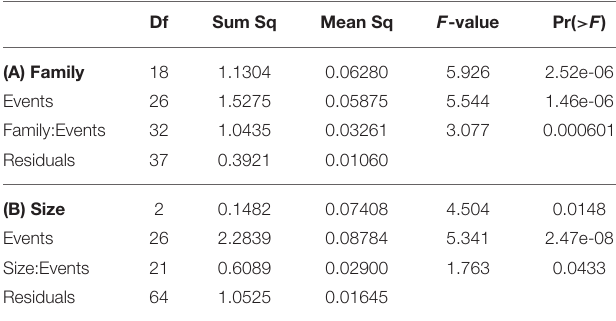
TABLE 2 | Summary of Two-Way Factorial ANOVA, testing interaction between decompression events and (A) taxonomic family and (B) body size (visually estimated in 3 size